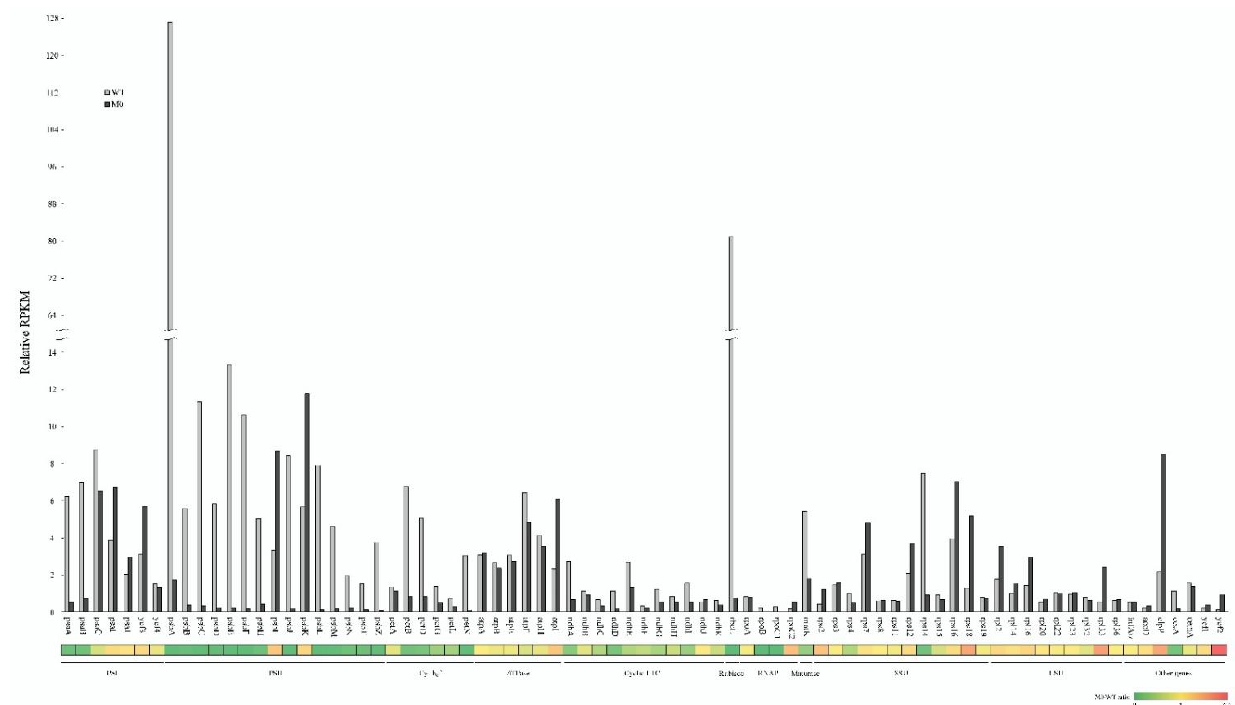
Figure 1. The relative expression levels of plastid protein-coding genes between PEP-deficient tobacco and wild-type plants. The relative RPKM analysis was used to measure the relative expression levels of plastid protein-coding genes by mapping the RNA-Seq reads from the leaf tissues of the PEP-deficient (M0) tobacco and wild-type (WT) plants to the cpDNA (NC_001879) template using the CLC Genomic Workbench with the parameters of length fraction (L) = 0.8 and similarity (S) = 0.8, with an exception for petN (L = 0.7; S = 0.8). The RPKM of the nuclear EF- 1α transcripts was used as a control for normalization, set to 1. The ratio of relative RPKM between M0 and the WT is illustrated as a heatmap at the bottom. PSI and PSII, Photosystem I and II; Cyt b6/f, Cytochrome b6/f complex; ATPase, ATP synthase complex; cyclic ETC, cyclic electron transport chain; Rubisco, ribulose 1,5-bisphosphate carboxylase/oxygenase; RNAP, RNA polymerase; SSU, ribosomal small subunits; LSU, ribosomal large subunits.